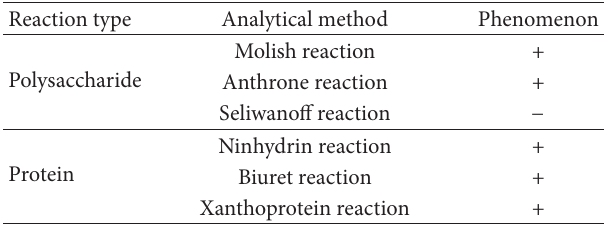
Table 2: Qualitative analysis of flocculent active ingredients. Reaction type